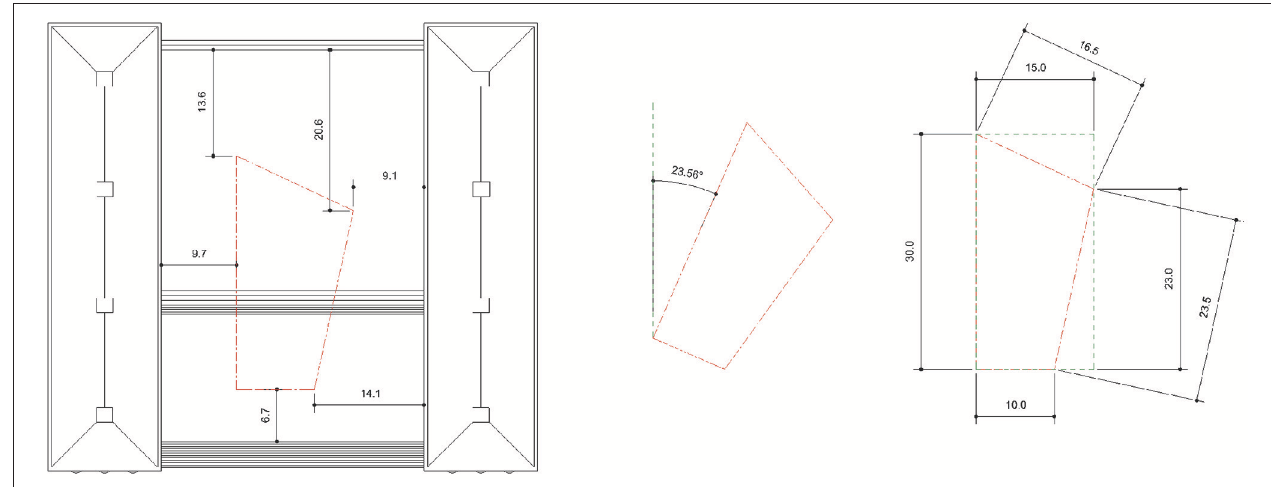
FIGURE 4 | The arbitrary polygonal building boundary on